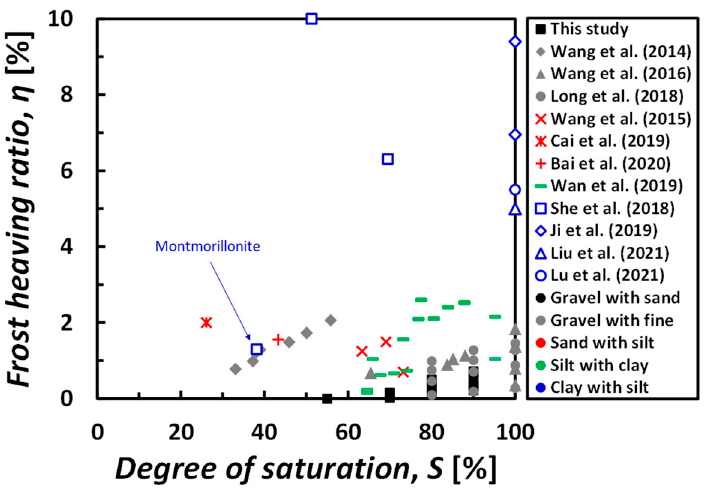
Figure 9. Frost heaving ratio for diverse soil types with respect to degree of saturation.